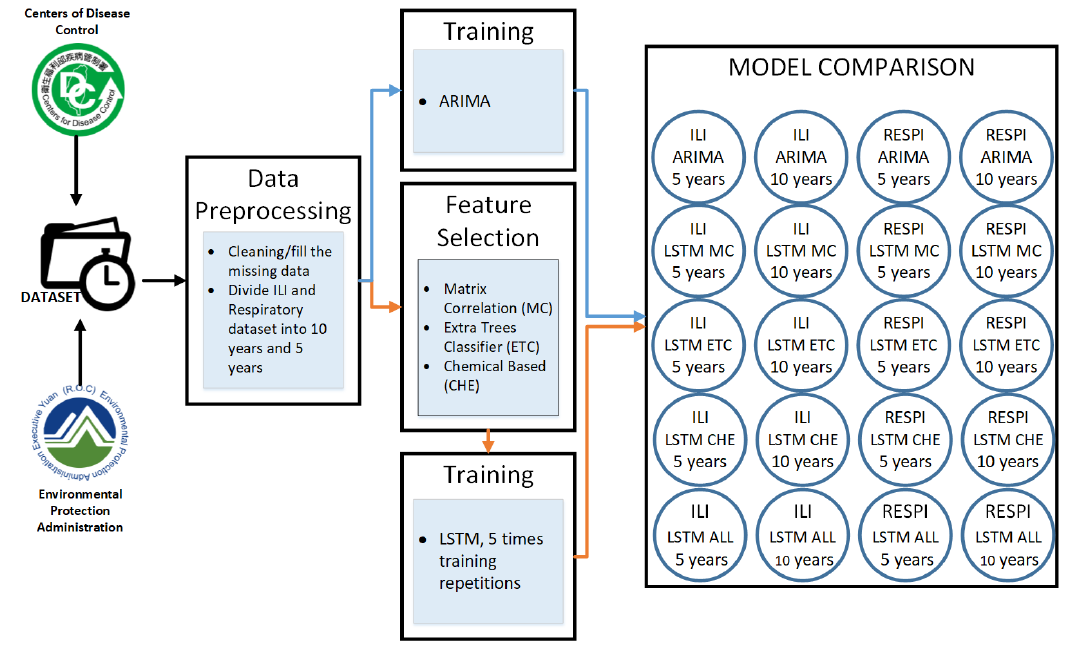
Figure 2. System